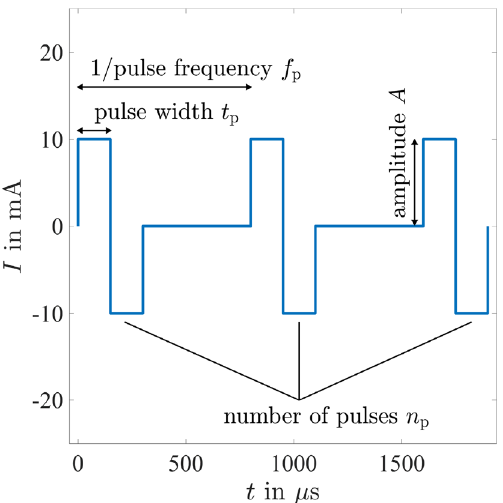
Figure 2. Example of the stimulation signal with biphasic rectangular pulses defined by amplitude ( A = 10 mA), pulse width ( t p = 150 µ s ), pulse frequency ( f p = 1250 Hz) and the number of pulses ( n p = 3